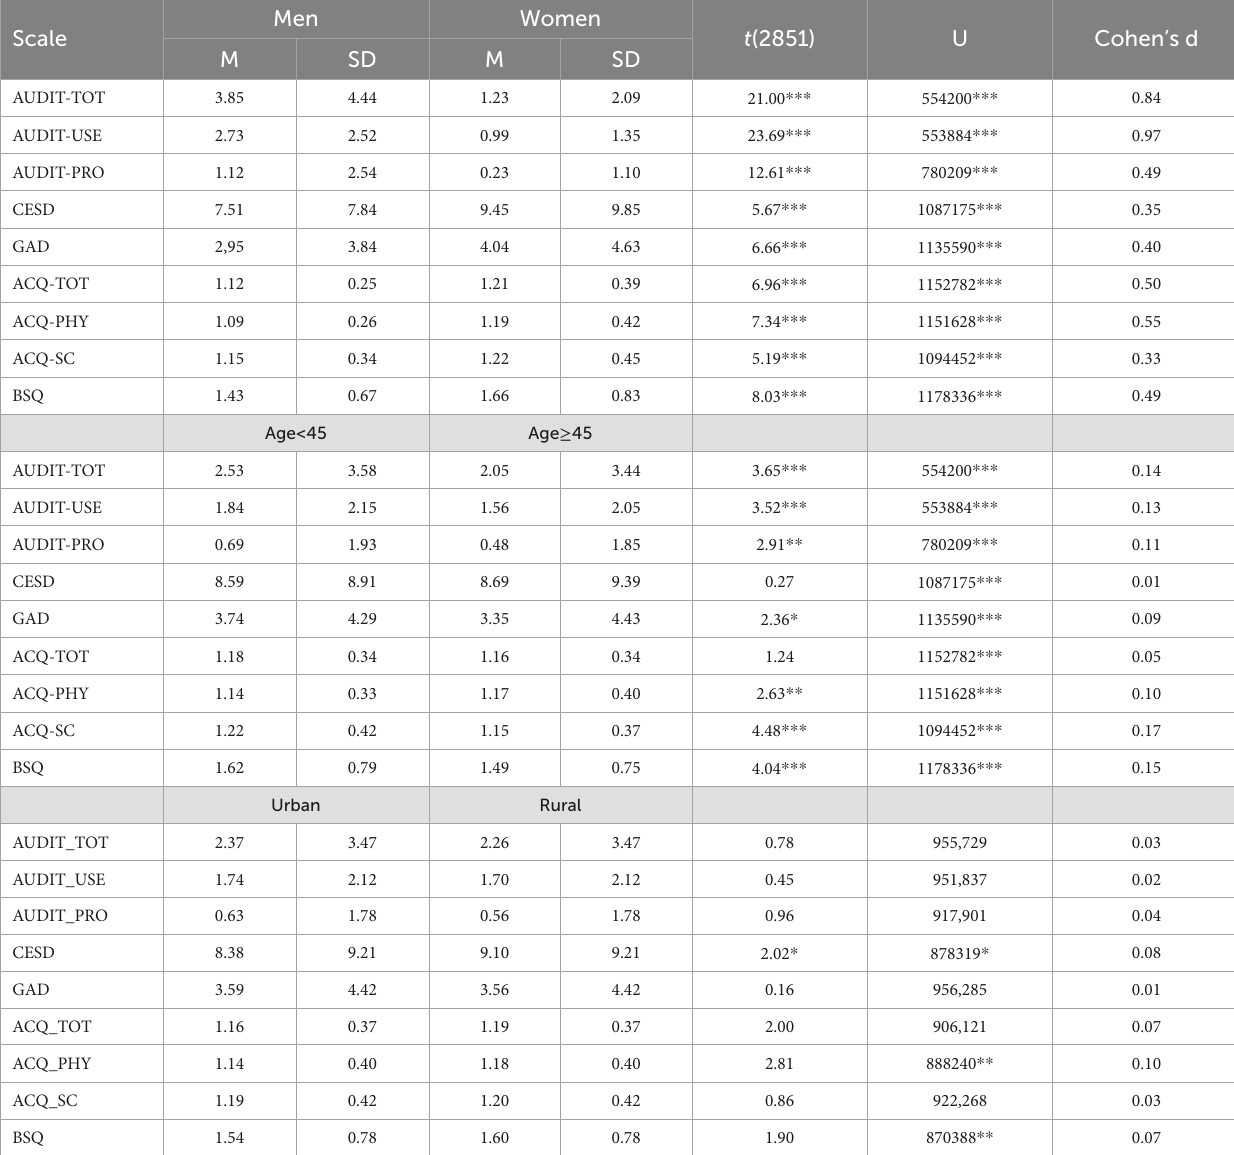
TABLE 5 Means and standard deviations for men and women, younger and older, and urban and rural respondents, results of t -test and Mann Whitney U tests and effect size (Cohen’s d). Men Women Scale